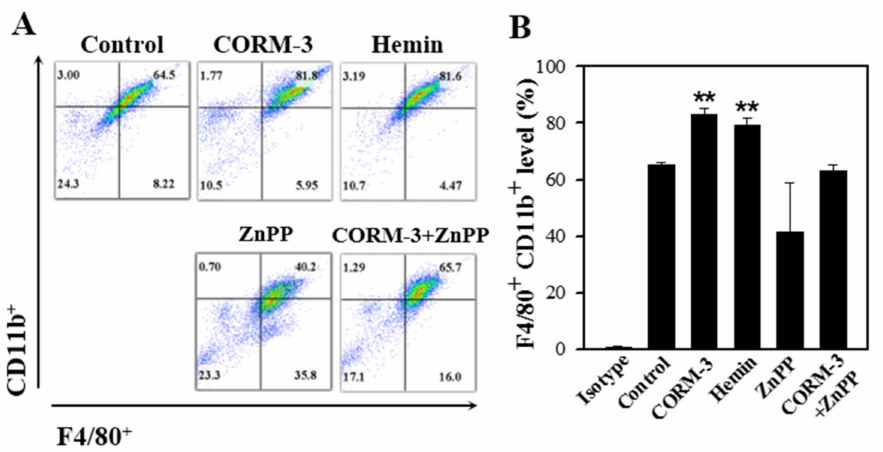
Figure 5. HO-1 inducer enhances macrophage differentiation and HO-1 inhibitor suppresses the differentiation. Murine BMCs were treated with 20 µ M hemin, 20 µ M ZnPP, or 20 µ M ZnPP with 100 µ M CORM-3 on day 5 and incubated for 5 days to induce macrophage differentiation. ( A ) Cells were fixed and stained with antibodies F4/80-FITC and CD11b-PE. Cells were acquired on FACSCalibur, X axis: F4/80 + , Y axis: CD11b + . ( B ) F4/80-positive and CD11b-positive cells were gated based on the isotype control. Results are presented as mean ± SD (n = 3 except n = 2 for CORM-3+ZnPP); ** p < 0.01 compared to control (one-way